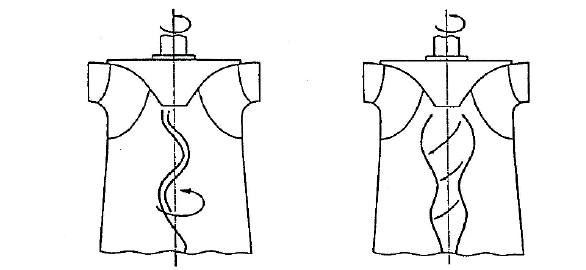
Fig. 2. Vortex rope in case of partload (left) and overload (right) turbine operation